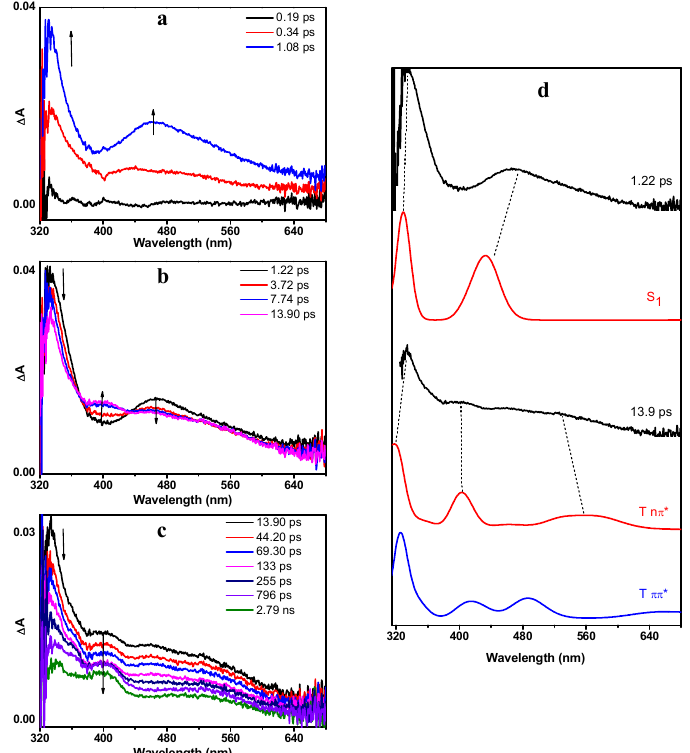
Figure 4. The fs-TA (femtosecond transient absorption) spectra of DMB in MeCN acquired after 266 nm irradiation ( a ) from 0.19 ps to 1.08 ps, ( b ) from 1.22 ps to 13.9 ps, ( c ) from 13.9 ps to 2.79 ns; ( d ) Comparison between the calculated absorption spectra of DMB (S 1 ), DMB (T n π *), DMB (T ππ *) and the fs-TA spectra recorded at 1.22 ps and 13.9 ps. The calculations were performed at the TD-B3LYP / 6-311 + g(d,p) (MeCN) level of theory. The scale factor is 1.05 (applied to energy ( x -axis)) and the half-width is 1000 cm − 1 .